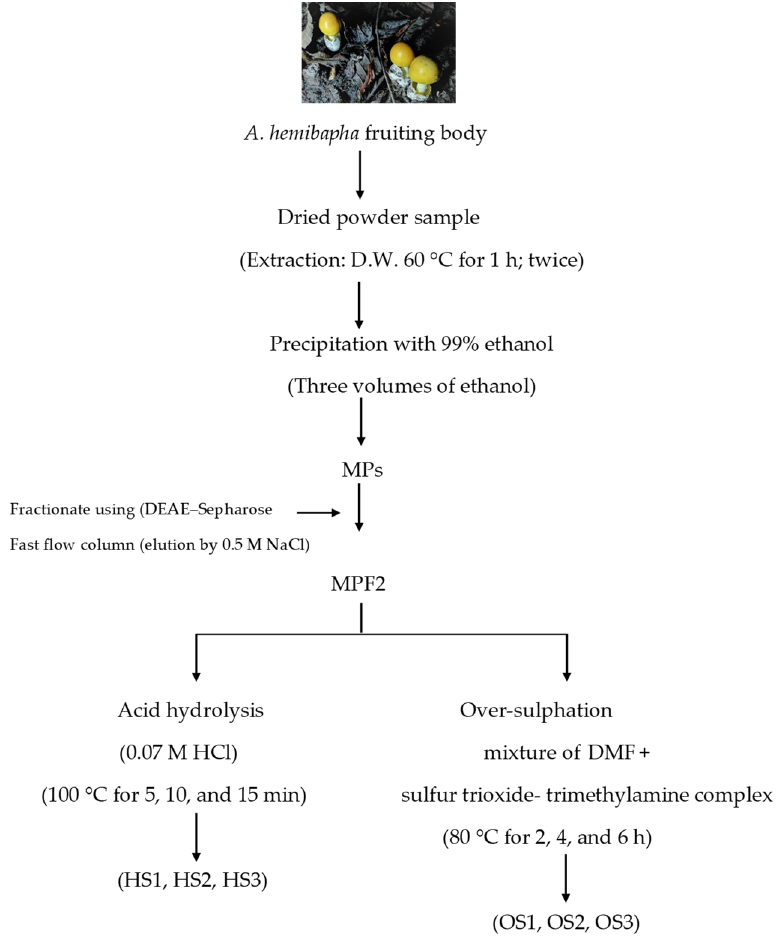
Figure 1. Extraction of polysaccharide (MP) and MPF2 modification process.